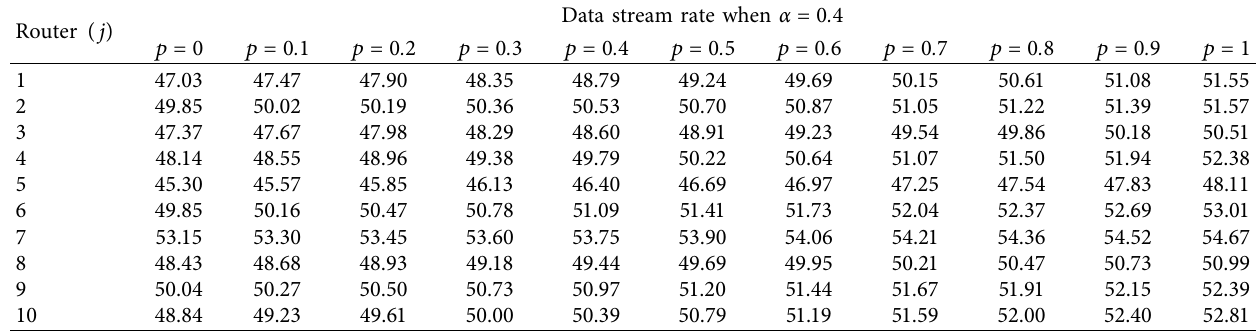
Table 6: Data stream rate for different values of p and α � 0 . 4. Data stream rate when α � 0 .